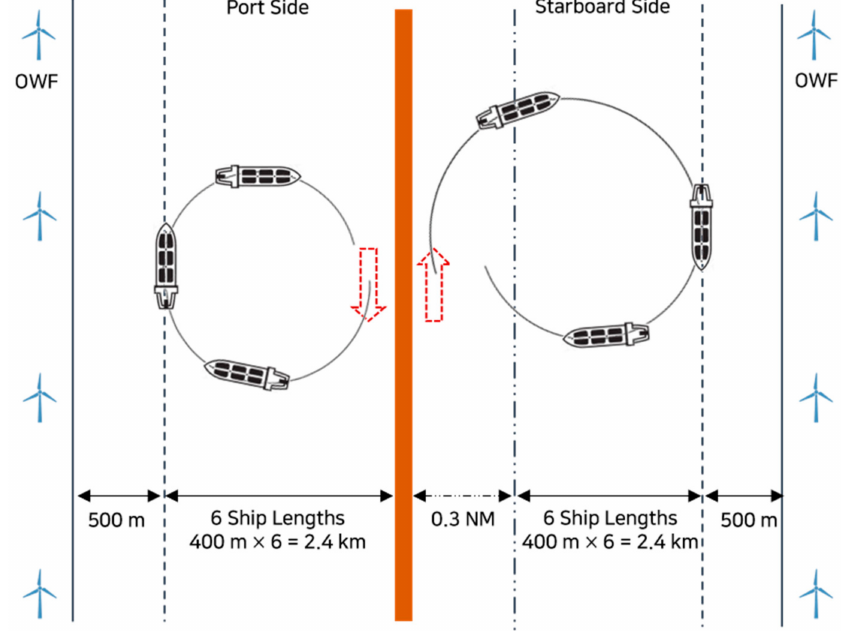
Figure 10. Safety distance between PIANC’s ship navigation and OWFs.